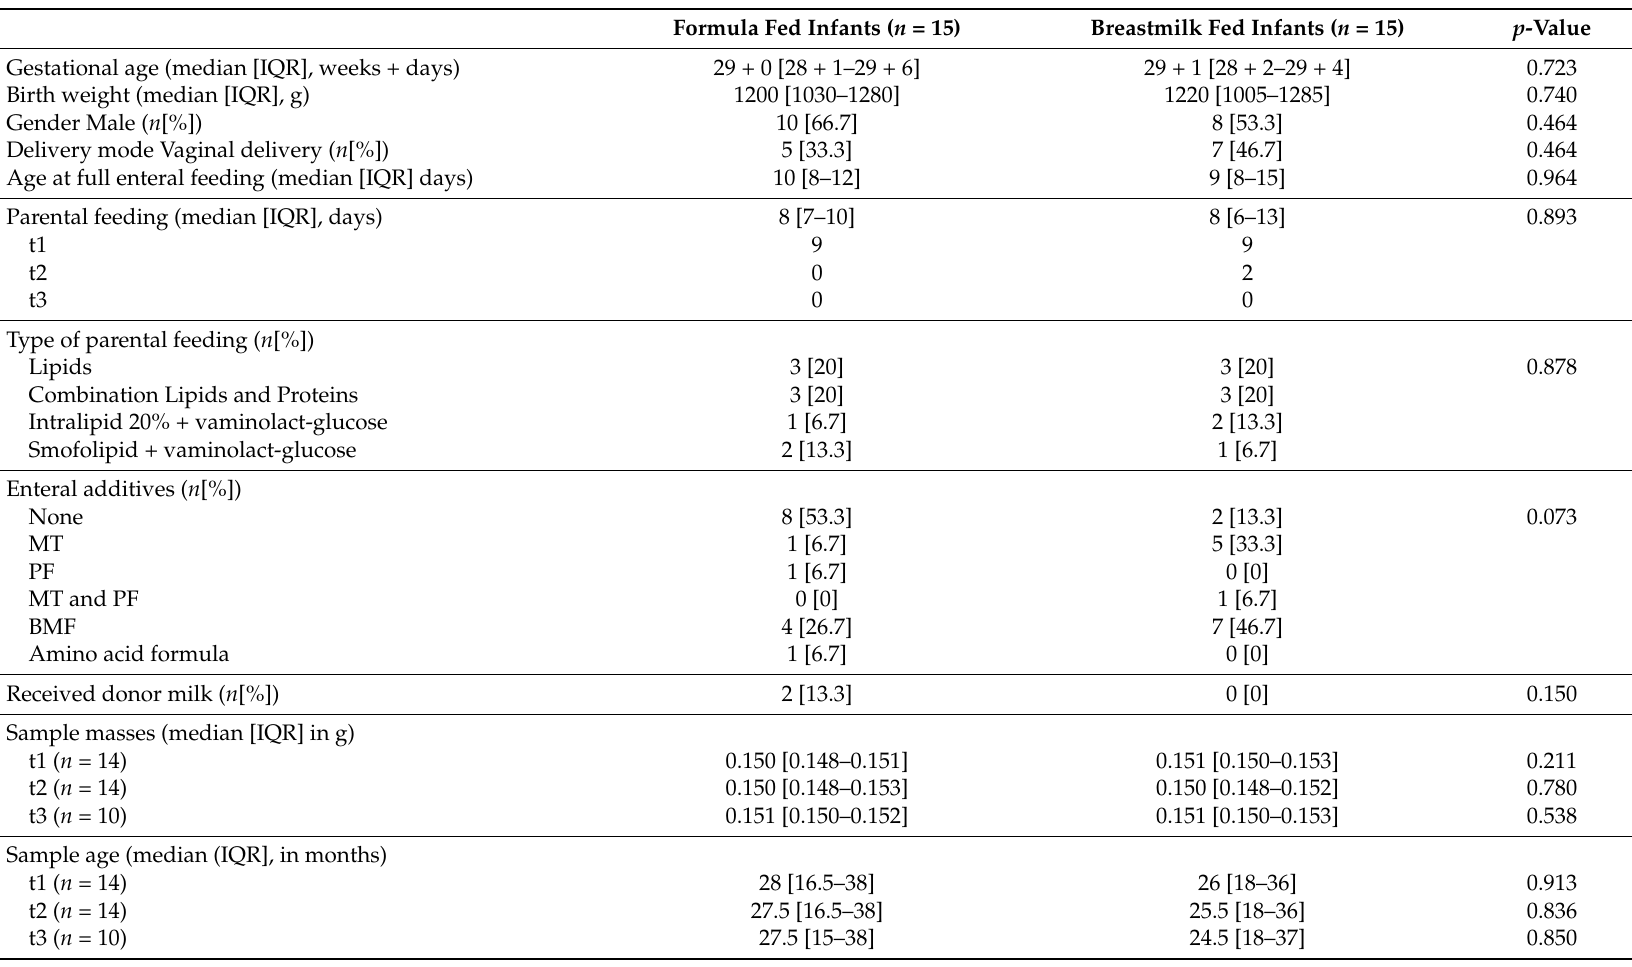
Table 1. Demographics patient